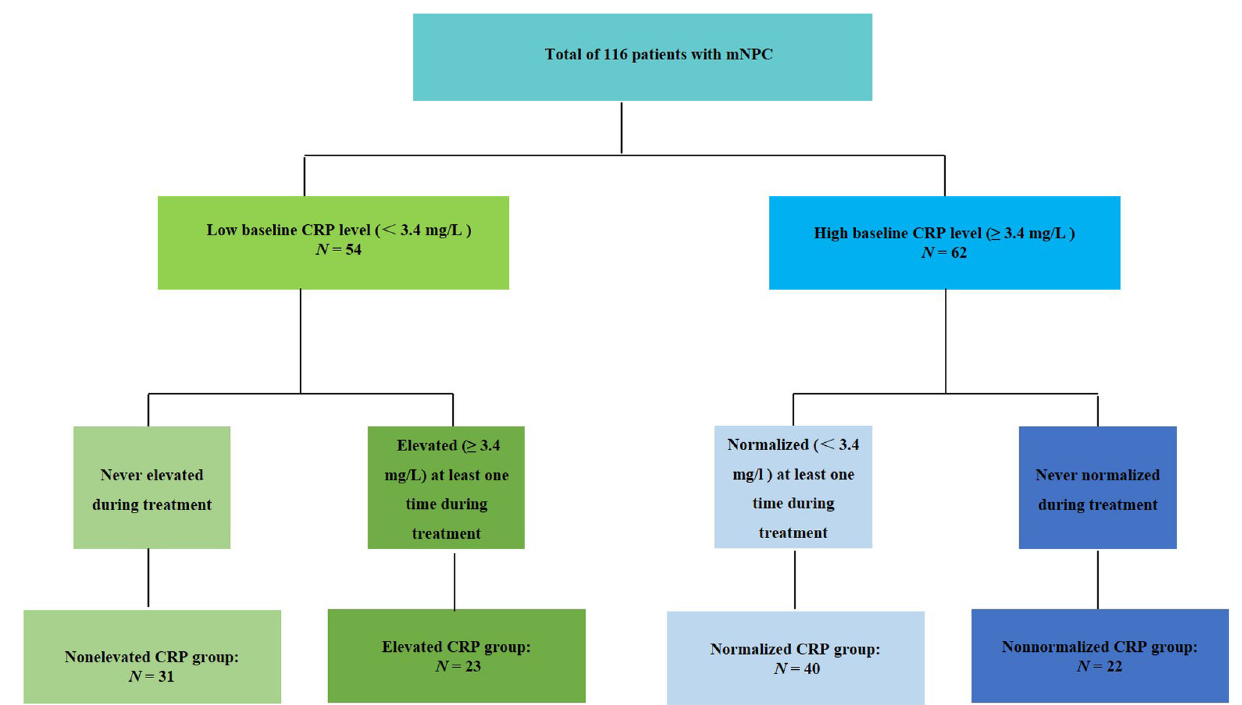
Figure 1. Flow chart of the different patients group according to C-reactive protein (CRP) kinetics. doi: